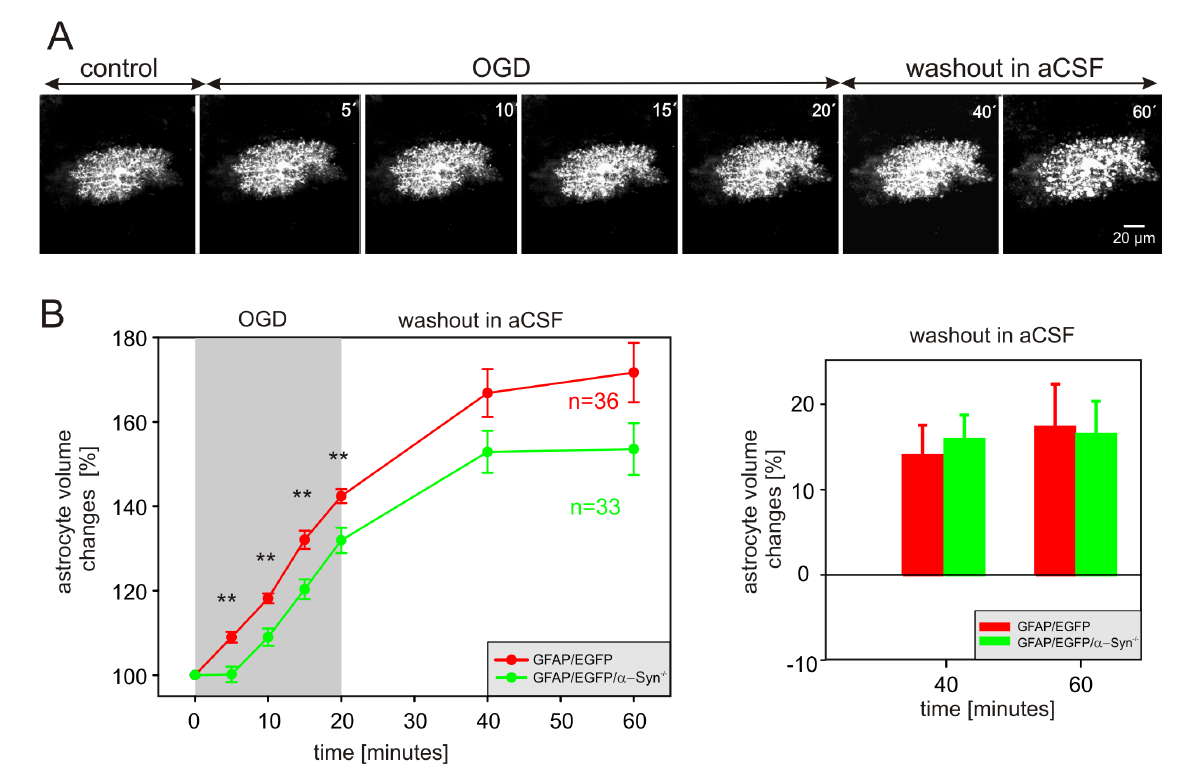
Figure 7. Astrocytic volume changes evoked by oxygen-glucose deprivation in the cortex of GFAP/EGFP or GFAP/EGFP/ a -Syn 2 / 2 mice. ( A ) Superimposed confocal images of an EGFP-labeled astrocyte in the cortex of a GFAP/EGFP/ a -Syn 2 / 2 mouse recorded in aCSF (control), during a 20- minute exposure to oxygen-glucose deprivation (OGD) and during a 40-minute washout. The astrocyte volume was quantified after every 5 minutes during OGD and every 20 minutes during washout. ( B left ) Time-dependent changes in the total astrocyte volume in the cortex of GFAP/EGFP (red) and GFAP/ EGFP/ a -Syn 2 / 2 mice (green) during 20-minute OGD and during a 40-minute washout. ( B right ) The changes of astrocyte volume during washout were evaluated in each individual cell and were expressed as an average percent of cell volume increase/decrease related to the maximal volume after 20 minutes of OGD, which was set as 0%. Asterisks indicate very significant (**, p , 0.01) differences between GFAP/EGFP and GFAP/EGFP/ a -Syn 2 / 2